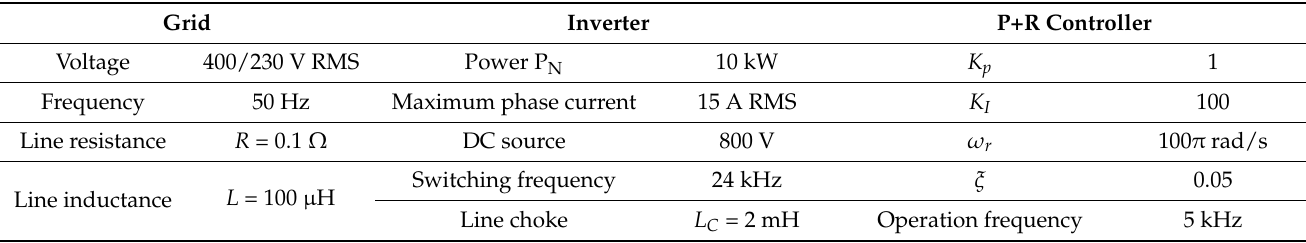
Table 1. Parameters of the tested